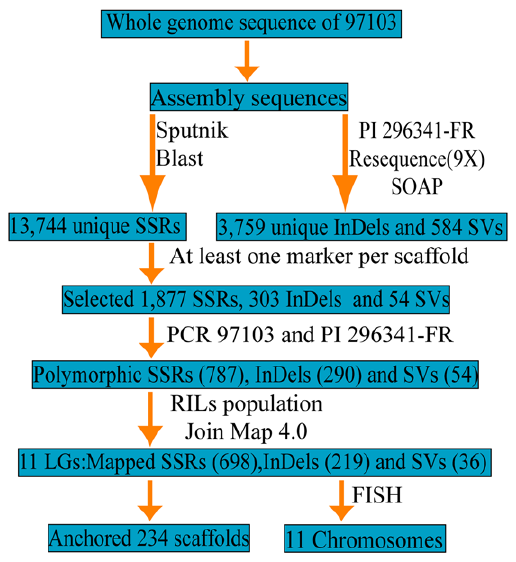
Figure 2. A schematic diagram of the development of watermelon SSR, InDel and SV markers.